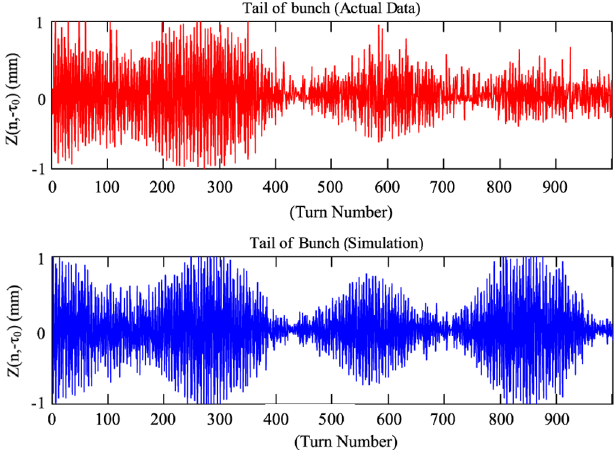
FIG. 9. (Color) Plot of measured and simulated Z (cid:3) n; (cid:1) (cid:4) versus n turns. Shown is the transverse (horizontal) turn-by-turn data of tail after a 1 mm kick 4 nsecs behind bucket center ( (cid:1) 4 nsecs ). Actual turn-by-turn data (top) compared with 1000 particle simulation with resistive wall wake W chromaticity (cid:4) (cid:5) 3 : 733 and (cid:8)